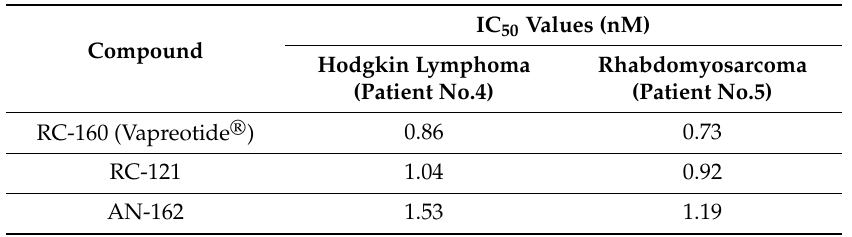
Table 2. Receptor binding potency (IC 50 values) of SST analogs to the membrane receptors of human pediatric cancer